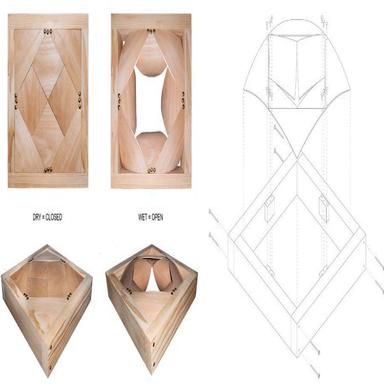
Comparison between the dry closed state and the wet open state of the modular panel (left); exploded axonometric of the modular panel (right).